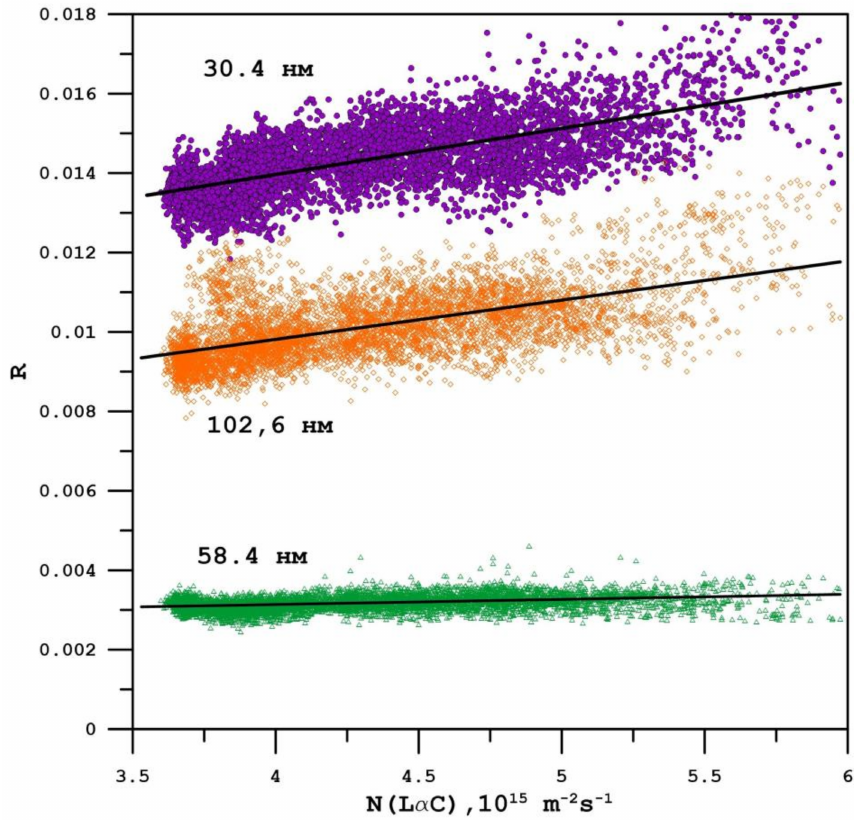
Figure 2. Changes in R λ values with the level of solar activity, as measured by the N (LaC) index. Purple — λ = 30.4 nm; orange — λ = 102.6 nm; green — λ = 58.4